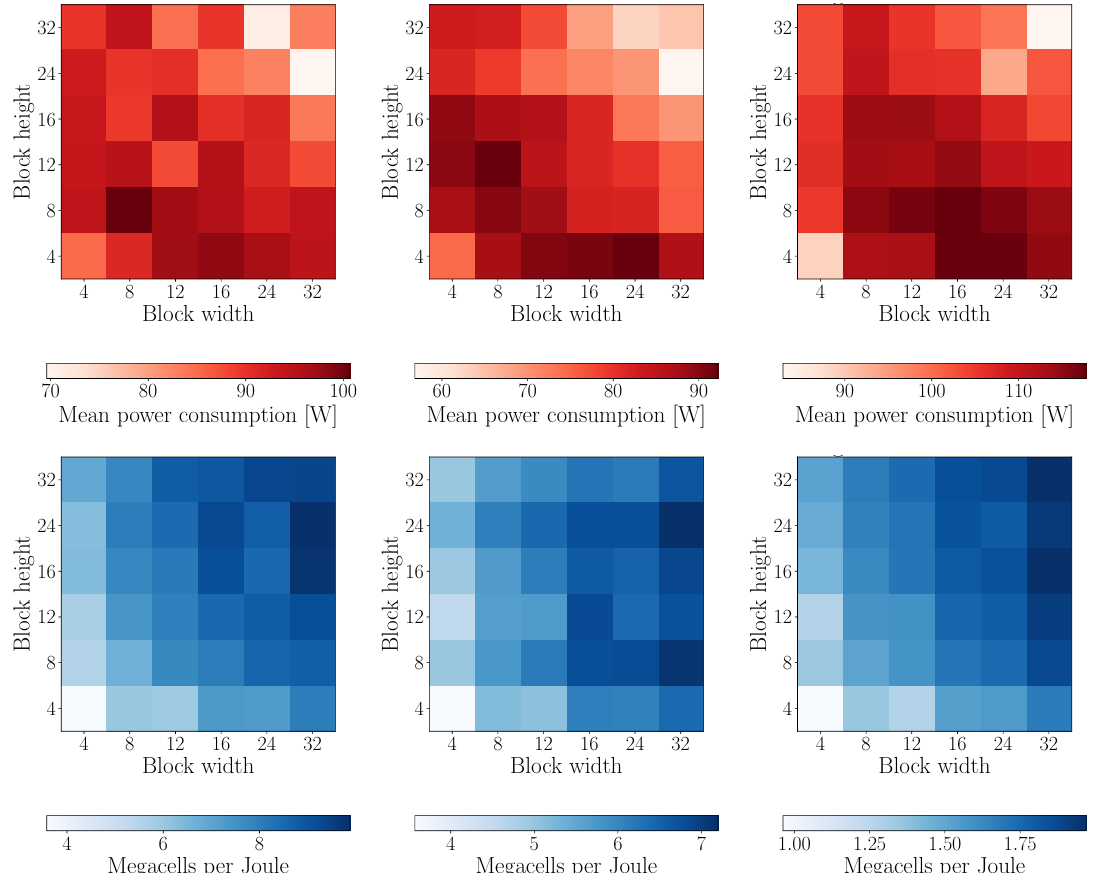
Figure 9. Computational performance (top), mean power consumption (middle), and energy efficiency (bottom) for the three numerical schemes for different block size configurations on the Tesla P100 GPU. Notice that all three measures change rapidly and unpredictably between the different configurations, and that there does not seem to be a direct translation between high computational performance and the mean power consumption. The bottom row shows that it is just as important to tune for optimal block size configuration when optimizing for energy efficiency as when optimizing for computational performance, and that these two objectives cannot be expected to be fulfilled